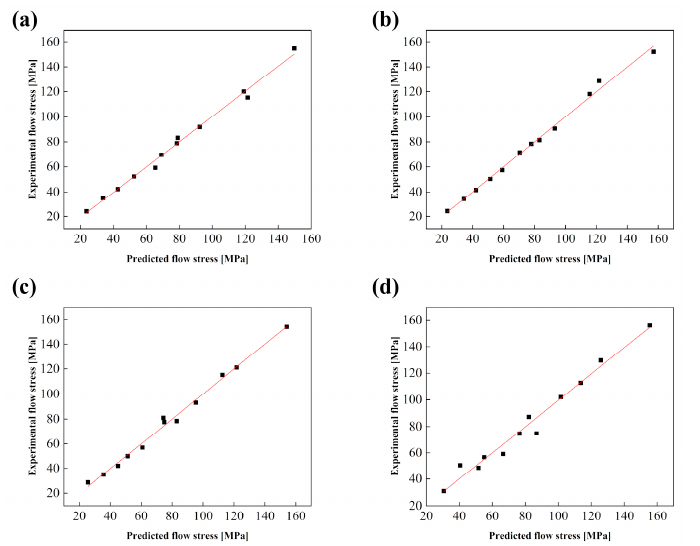
Figure 5. The correlation of experimental flow stress and predicted values for true strains of ( a ) 0.69, ( b ) 0.92, ( c ) 1.20 and ( d )